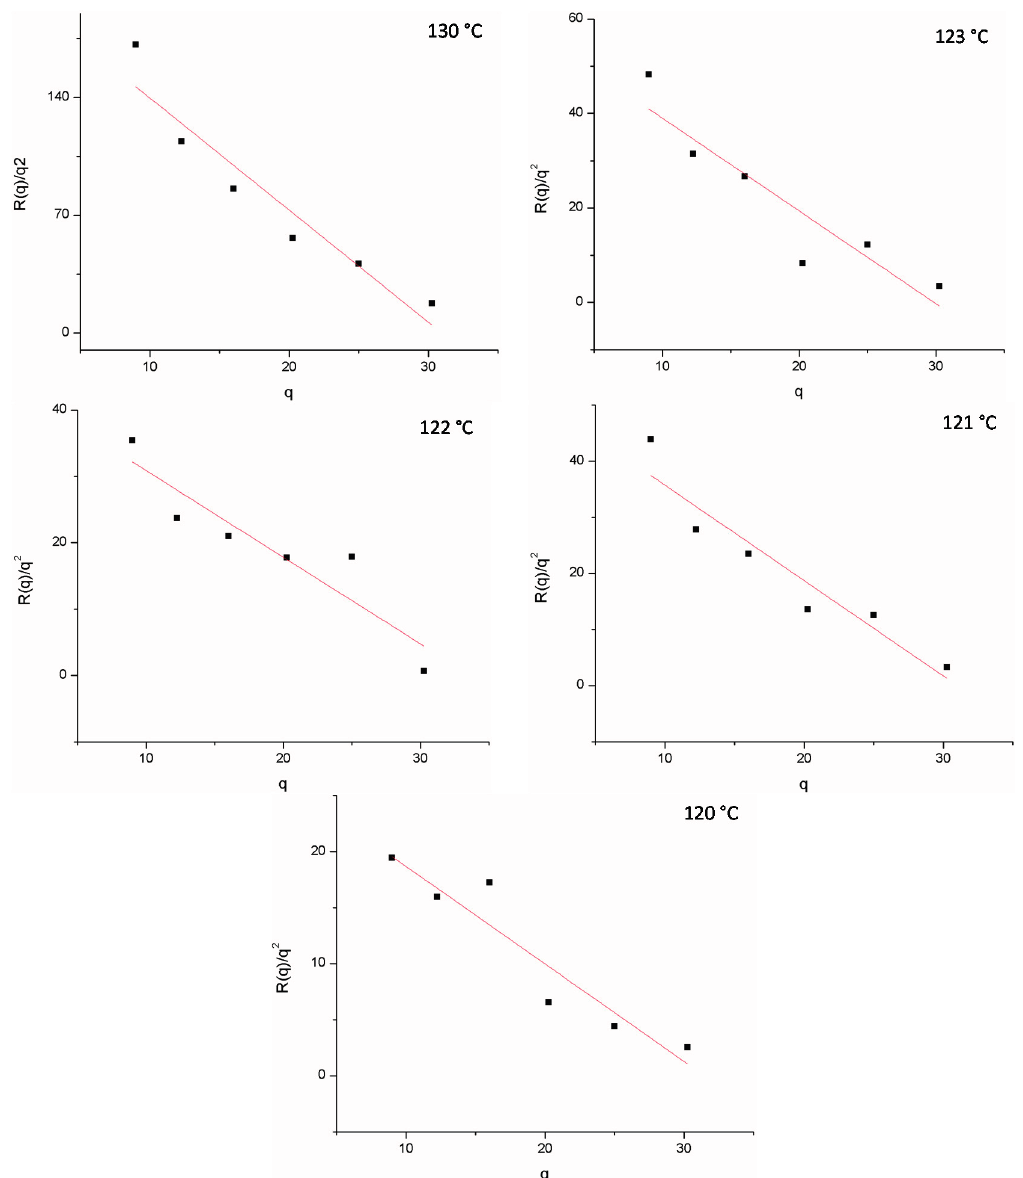
Figure 4. Linear relation between R ( q )/ q 2 and q